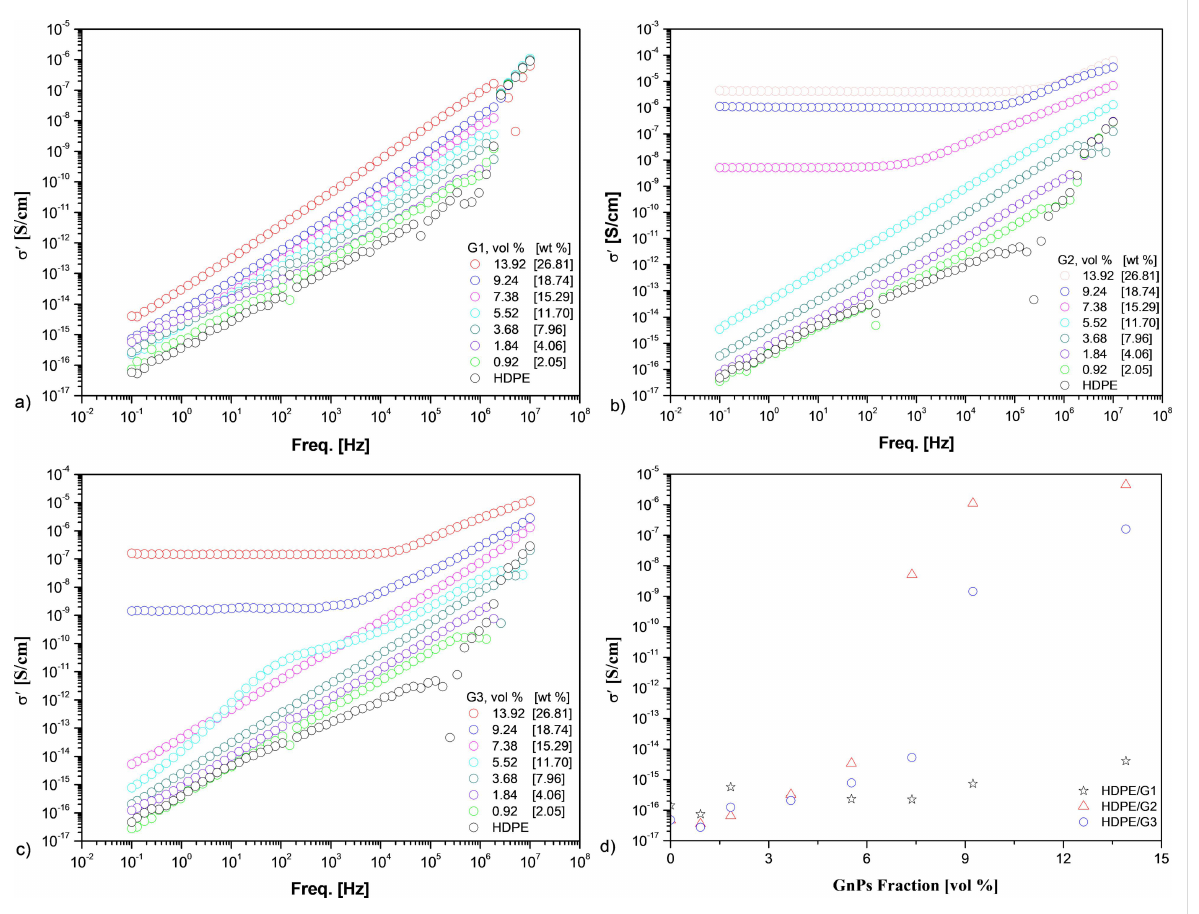
Figure 4: Real part of AC electrical conductivity vs frequency for a) HDPE/G1, b) HDPE/G2, and c) HDPE/G3 nanocomposites as well as d) σ ´ AC at 0.1 Hz vs vol % of GnP for the HDPE/GnP nanocomposites.